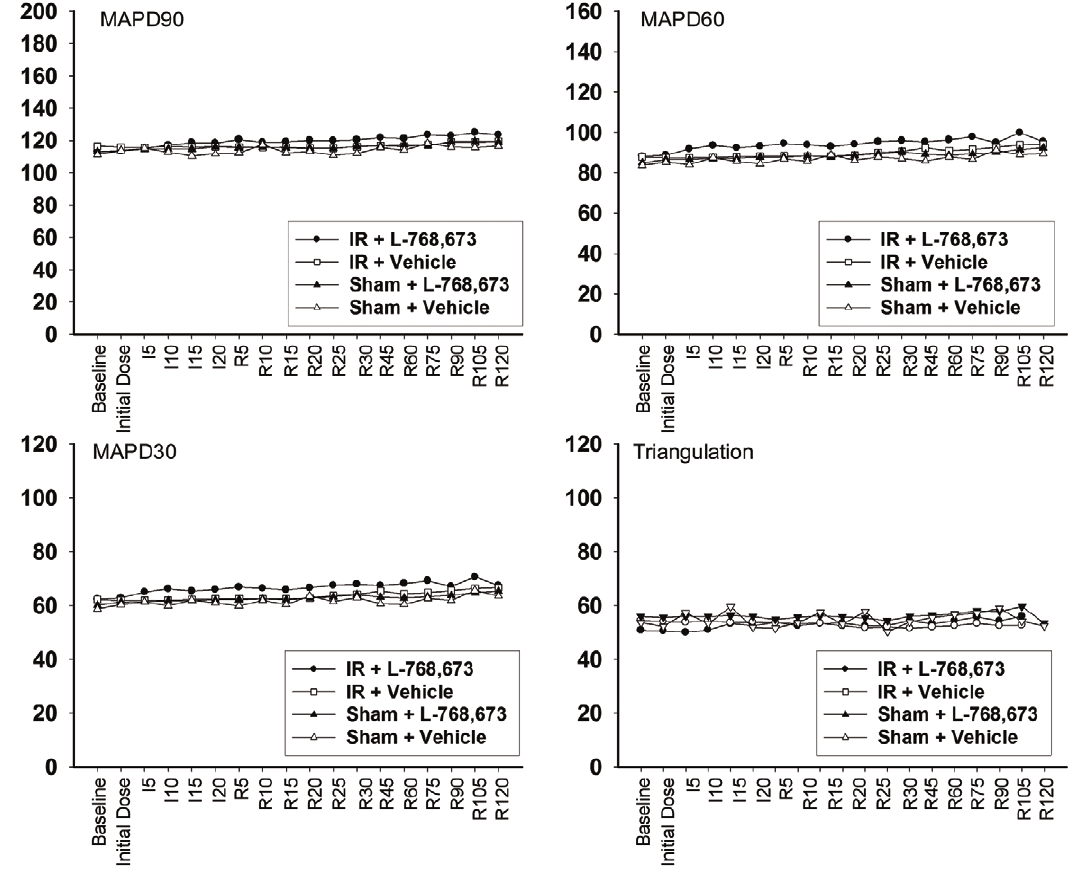
Figure 3. Epicardial MAPD90/60/30 and triangulation (MAPD90 - MAPD30) recorded from the remote zone (basal). Results were means 6 STD. There were no significant differences between groups.